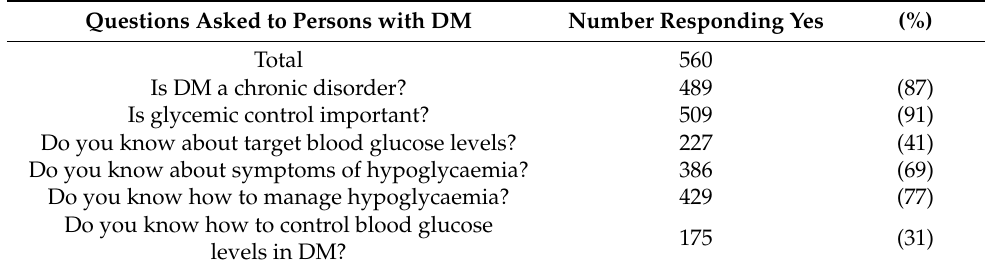
Table 3. Awareness about diabetes mellitus in persons with diabetes mellitus attending primary health care facilities, Kerala, India,